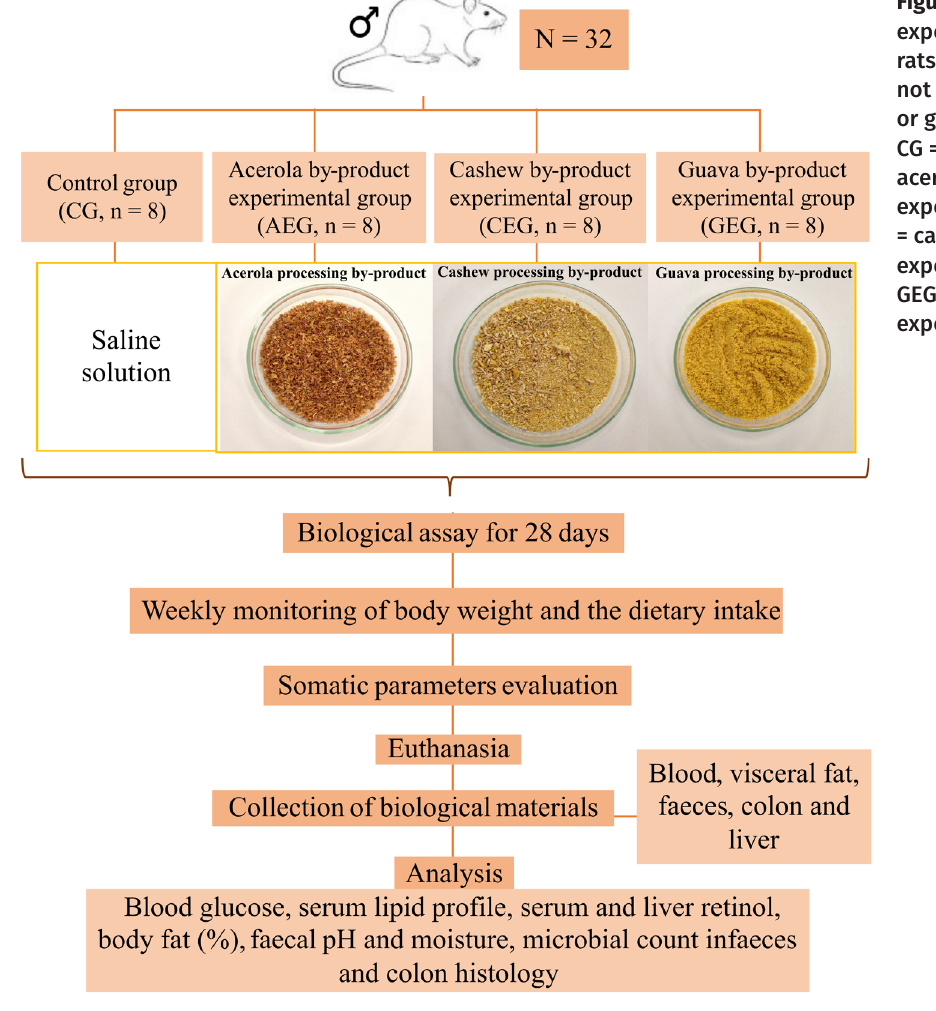
Figure 1. Flowchart of the experimental study with rats supplemented or not with acerola, cashew, or guava by-products. CG = control group; AEG= acerola by-product experimental group; CEG = cashew by-product experimental group; GEG= guava by-product experimental